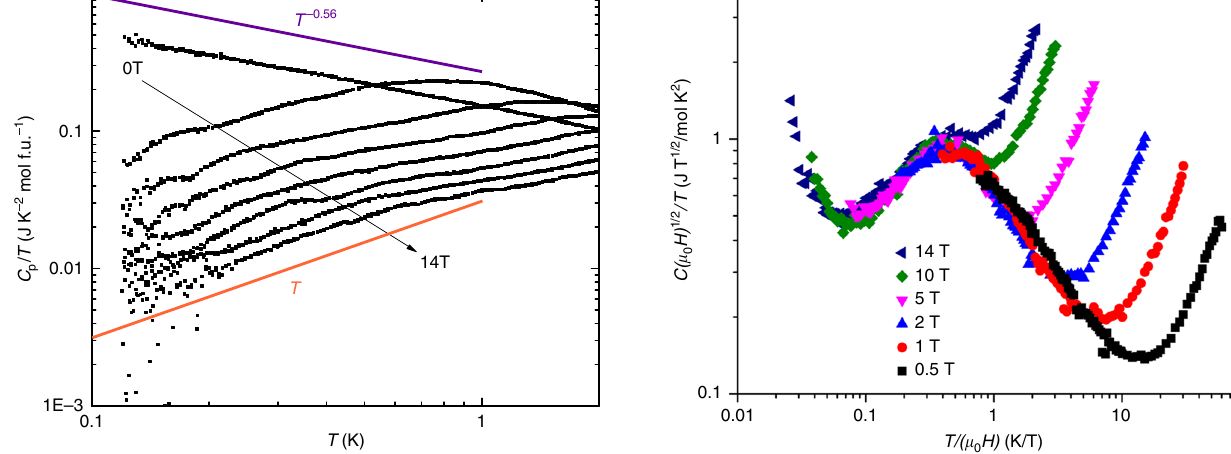
Fig. 4 Data collapse in synthetic herbertsmithite ZnCu 3 (OH) 6 Cl 2 . Herbertsmithite heat capacity data from ref. 17 , here replotted using the scaling ansatz H 0.5 C / T (per formula unit of ZnCu 3 (OH) 6 Cl 2 ) to show data collapse. The phonon contribution has not been subtracted, which accounts for the upturn for T / H ≳ 1. Away from the upturn at low T / H ≲ 0.05, which is due to the nuclear Schottky contribution, the data collapses with a peak consistent with the scaling function Eq. (2) and Fig.